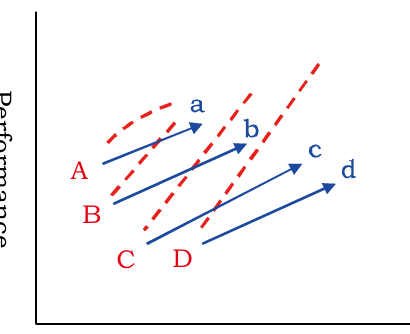
Figure 3. Performance (dashed red line) outstrips required performance level (solid blue line) Source : Simplified version of Figure 2 from Christensen and Bower